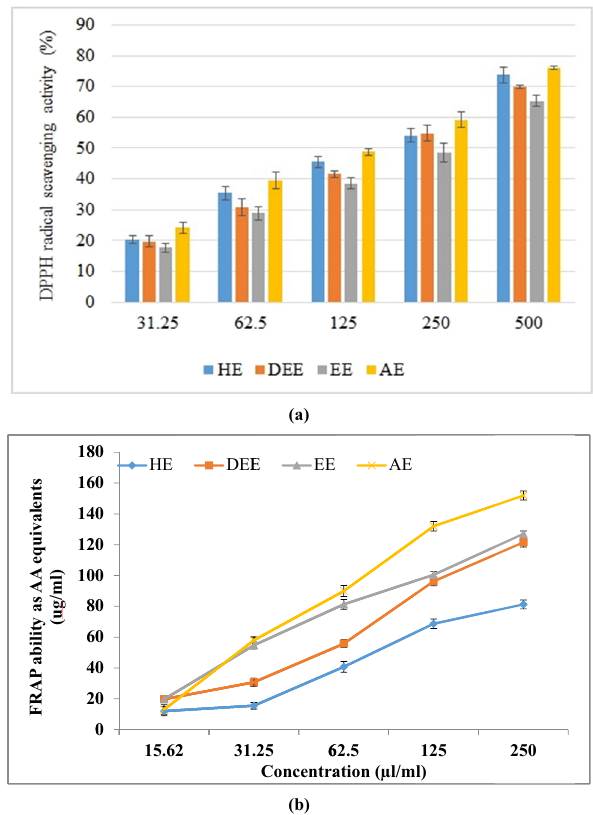
Figure 1: DPPH radical scavenging activity ( a ) and ferric reducing antioxidant power ability ( b ) of R. mucronata leaf